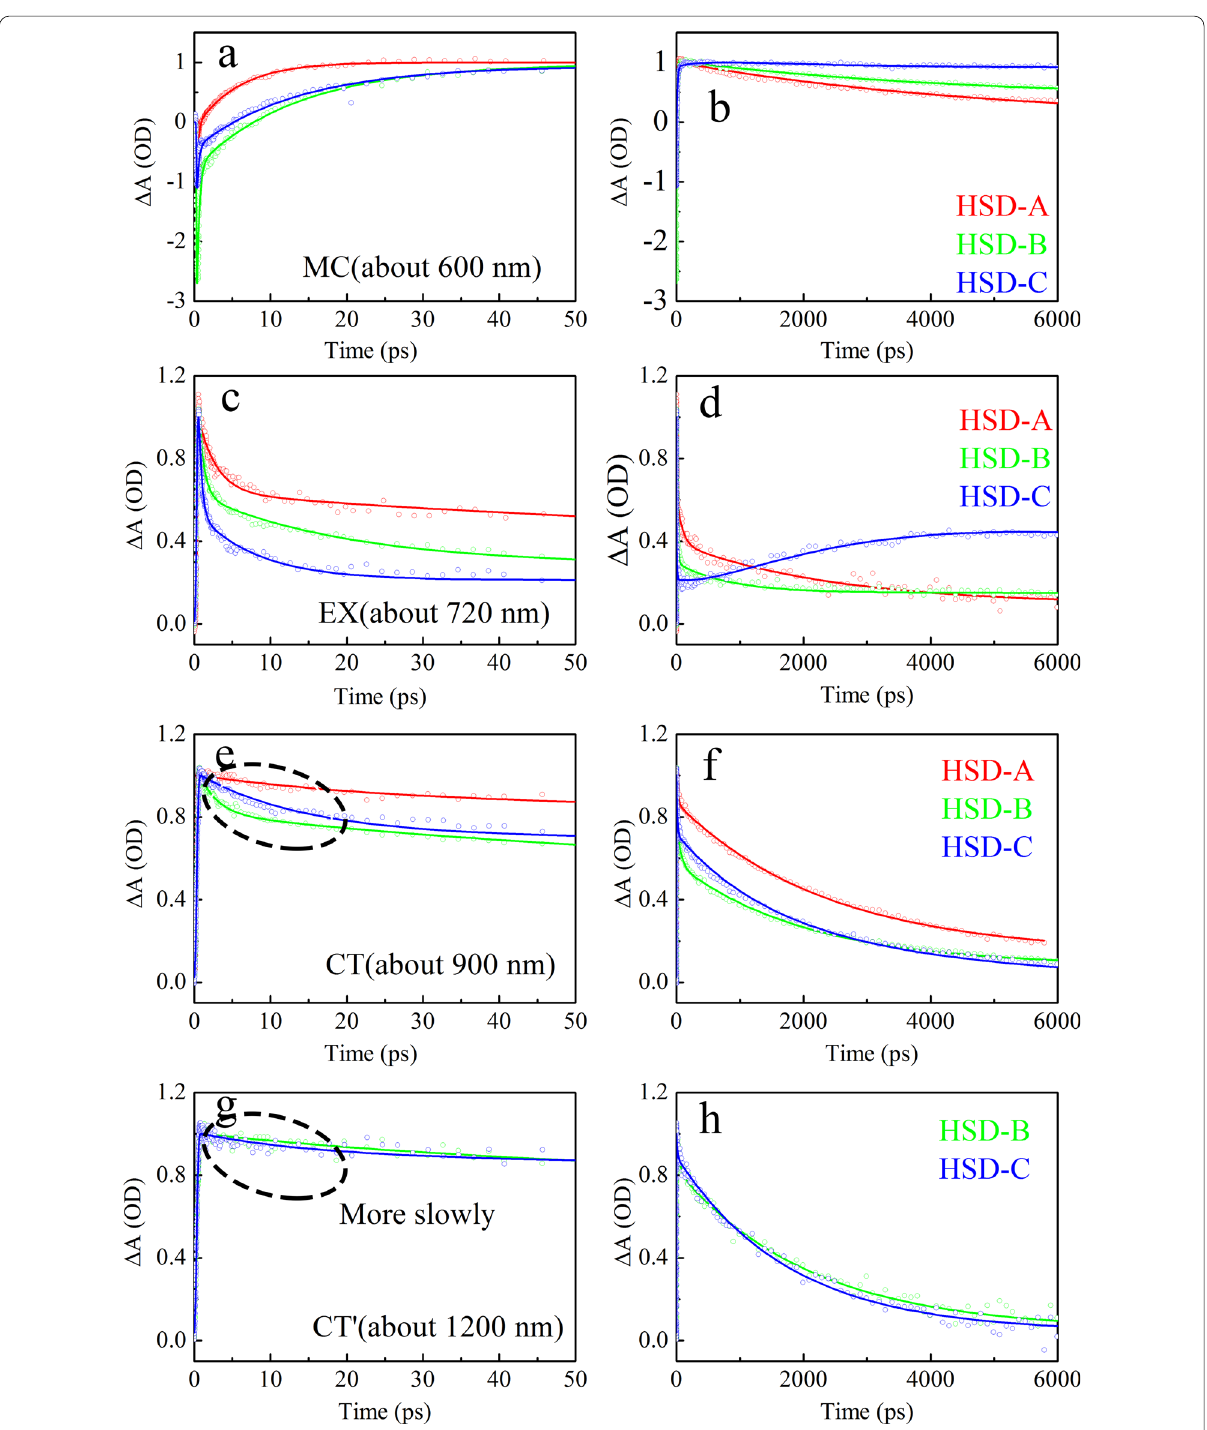
Fig. 7 Kinetics fit of all transient spectral characteristics of three samples. The figure shows the kinetics of 50 ps ( a , c , e ) and 5000 ps ( b , d , f ). Fits are for MC ( a , b ), EX ( c , d ), CT ( e , f ), CT ′ ( g , h ) spectrum